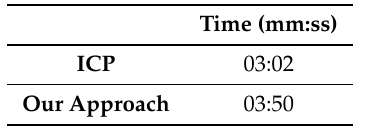
Table 1. 3D alignment processing times for the MeetingRoom dataset.